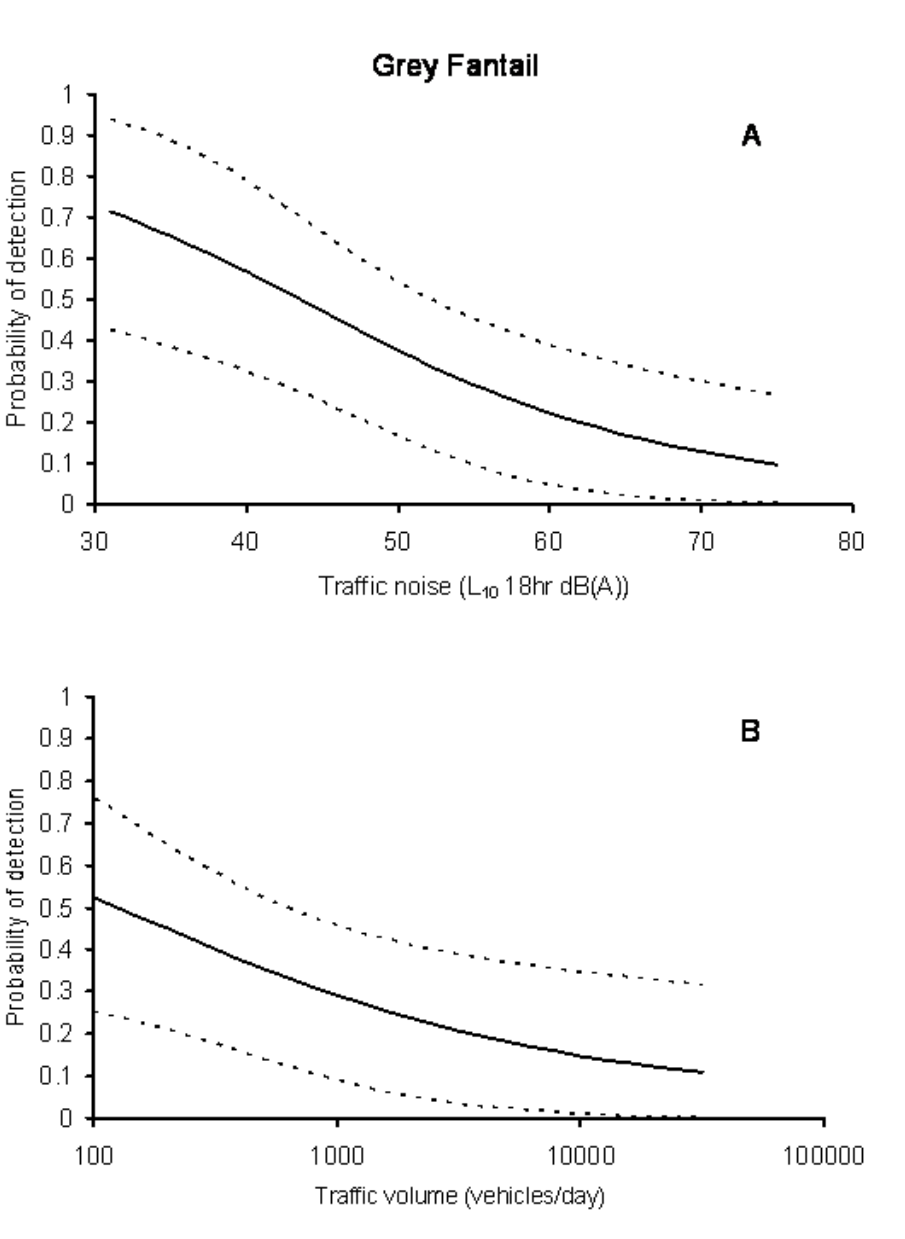
Fig. 5 . Predicted probability of detecting the grey fantail on a visit to a site as a function of (A) traffic noise and (B) traffic volume, across all 58 sites. The solid lines show the predicted relationships and dashed lines the 95% credible